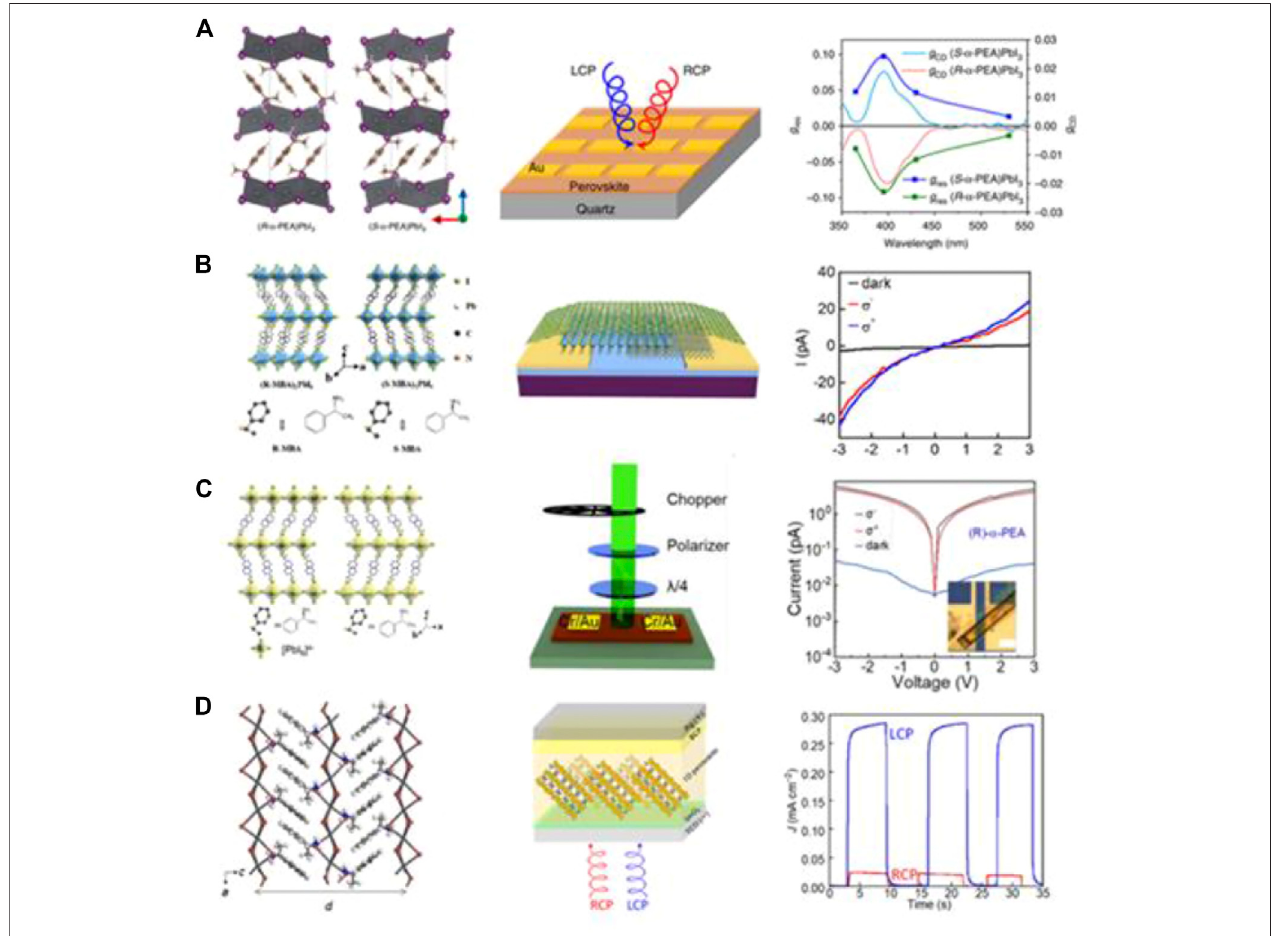
FIGURE 7 | (A) Crystal structure of ( S )-( α -PEA) 2 PbI 4 and ( R )-( α -PEA)PbI 3 . Schematic diagram of ( S )-( α -PEA)PbI 4 and ( R )-( α -PEA)PbI 3 fi lm photodetectors. Wavelength-dependent g res spectra of ( S )- and ( R )-( α -PEA)PbI 3 thin fi lm photodetectors. Reproduced with permission (Chen et al., 2019). Copyright 2018, Nature Publishing Group. (B) Schematic illustrations of the crystal structures of ( R -and S -MBA) 2 PbI 4 , schematic illustration of the (R-MBA) 2 PbI 4 microplate photodetector,